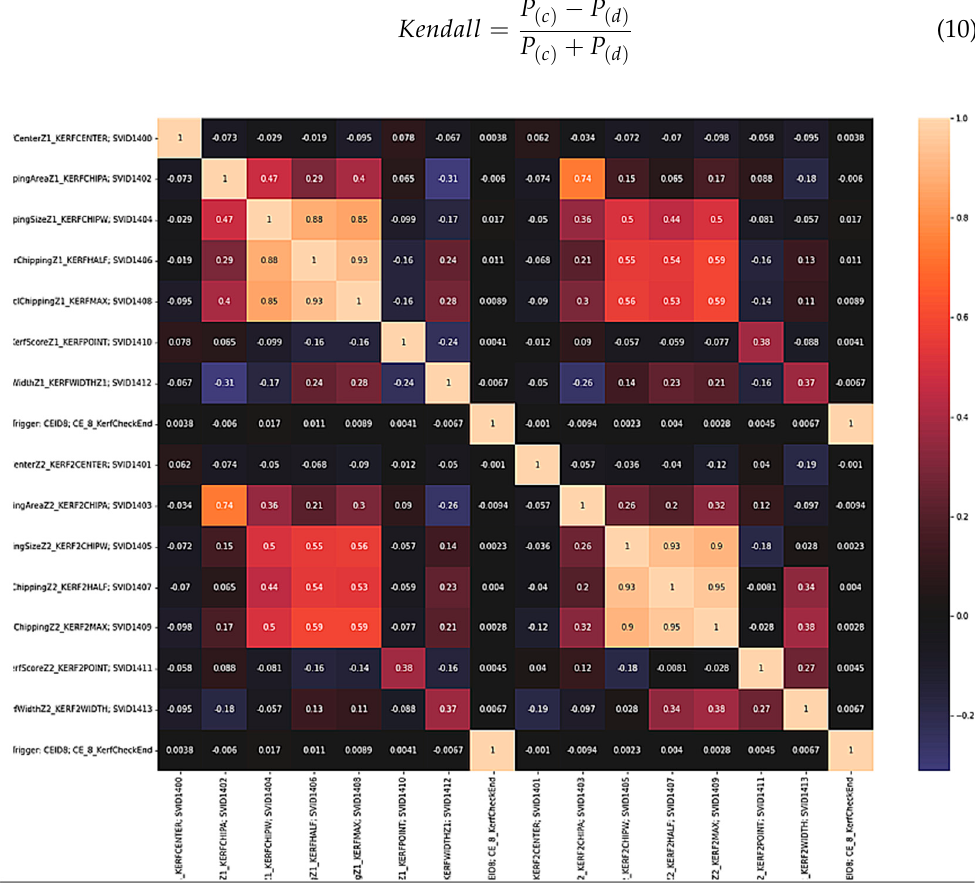
Figure 15. Time series of parameter SVID_1753 in the wafer ID TR7W1101W04F7.